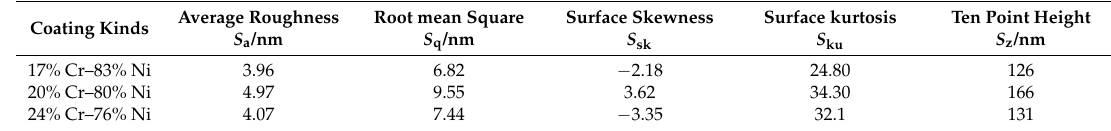
Table 2. Surface roughness of Cr–Ni coatings with different mass ratios of Cr and Ni.